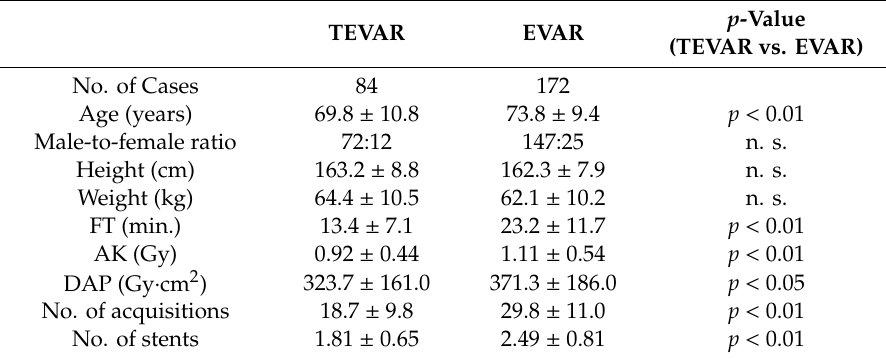
Table 3. A summary of our results: patient data and radiation